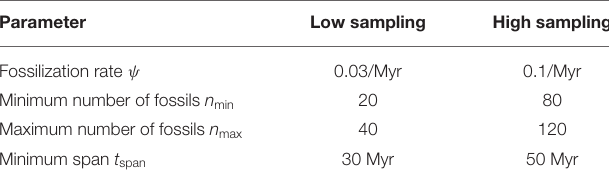
TABLE 1 | Parameters values for low and high fossil sampling